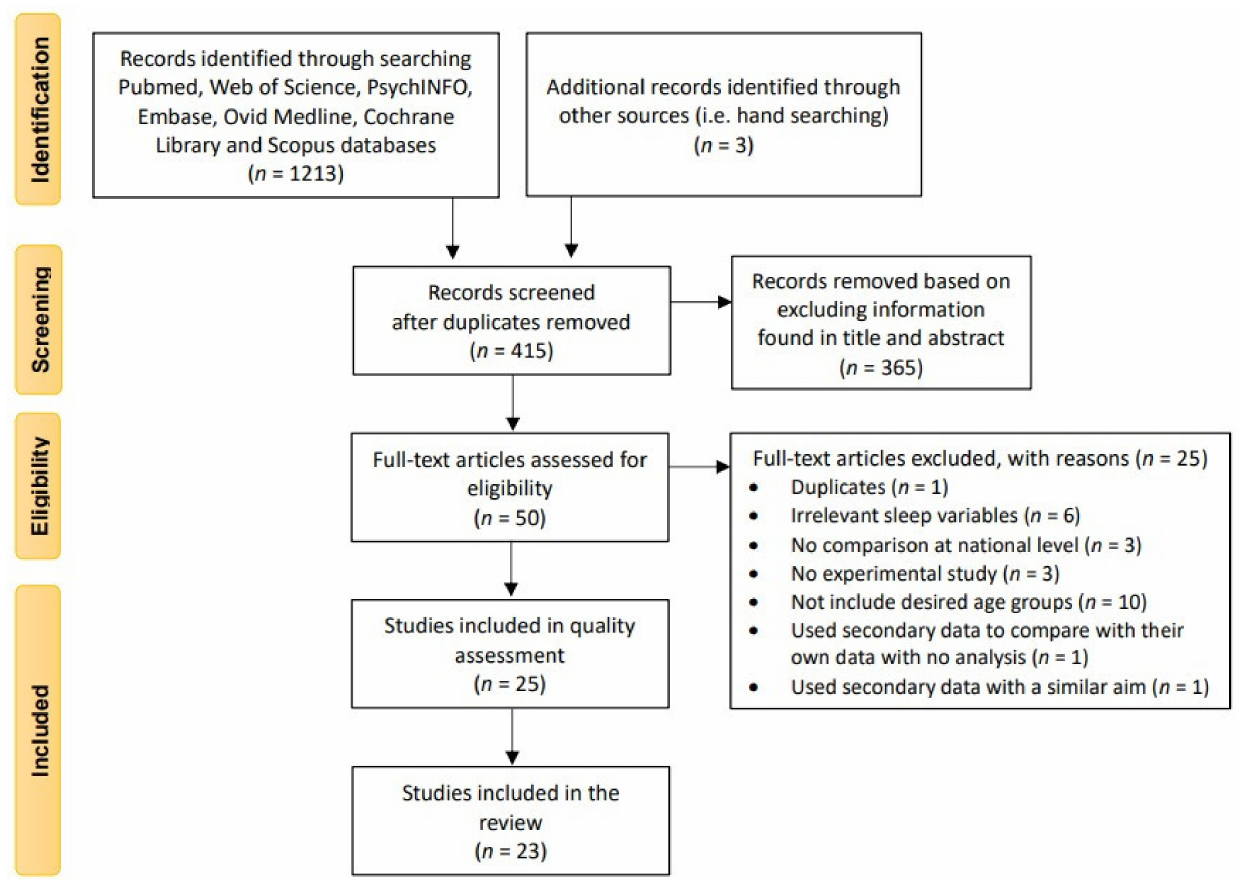
Figure 1. Flow diagram for the systematic search